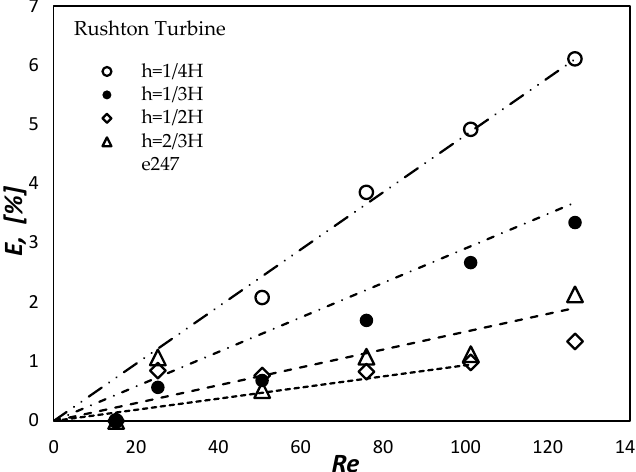
Figure 12. The mixing efficiency evaluated from experimental measurement for the Rushton turbine and different distances from the tank bottom.